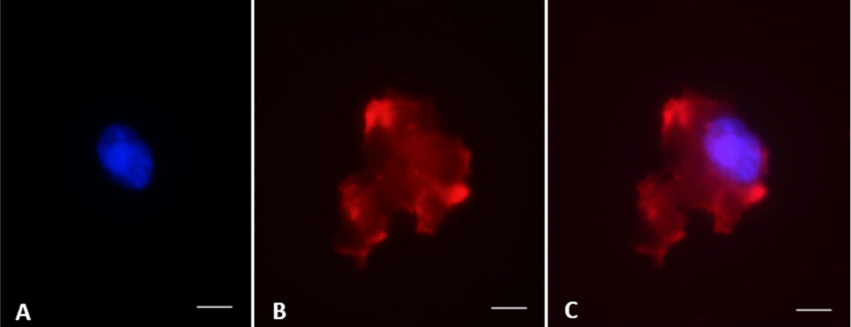
Figure 4. Immunostaining of vimentin in testicular cells from black-footed ferret. ( A ) Nucleus stained with Hoechst, ( B ) presence of vimentin in the cytoplasm, ( C ) merged image. Bar = 5 µ